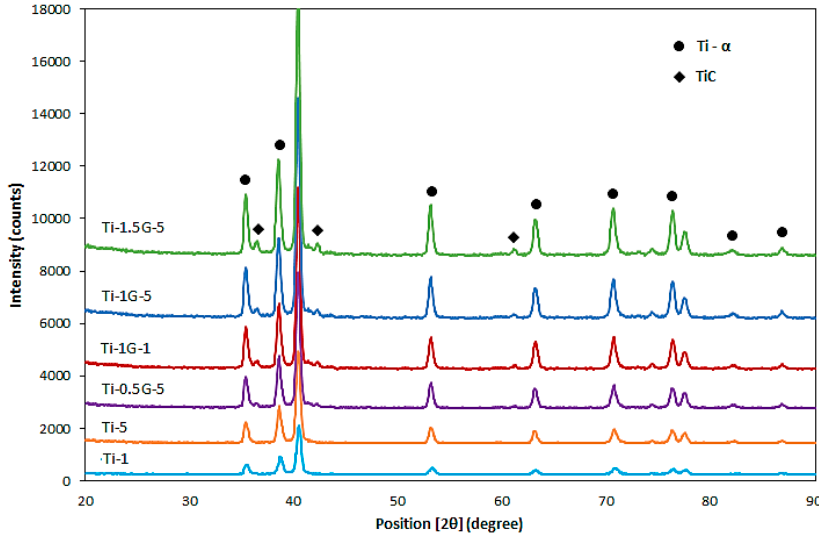
Figure 3. XRD patterns of Ti/GNS composites fabricated at various conditions.